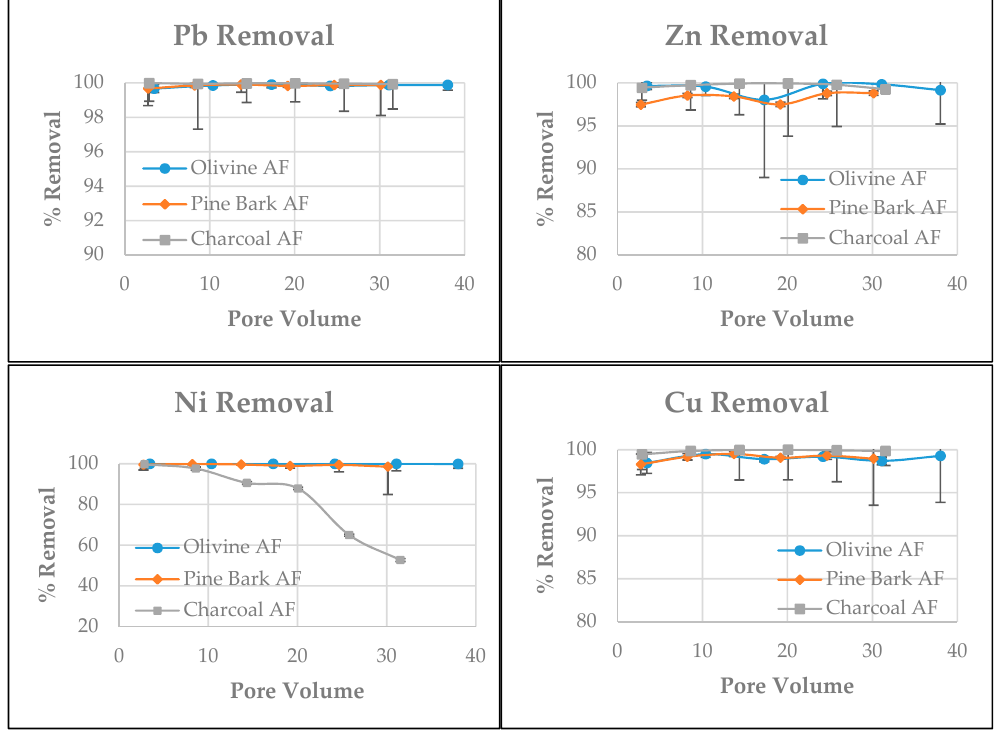
Figure 2. Percentage removal of the four toxic metals as a function of pore volume. Note that the Y-axis is different in each case. AF stands for amended filter.